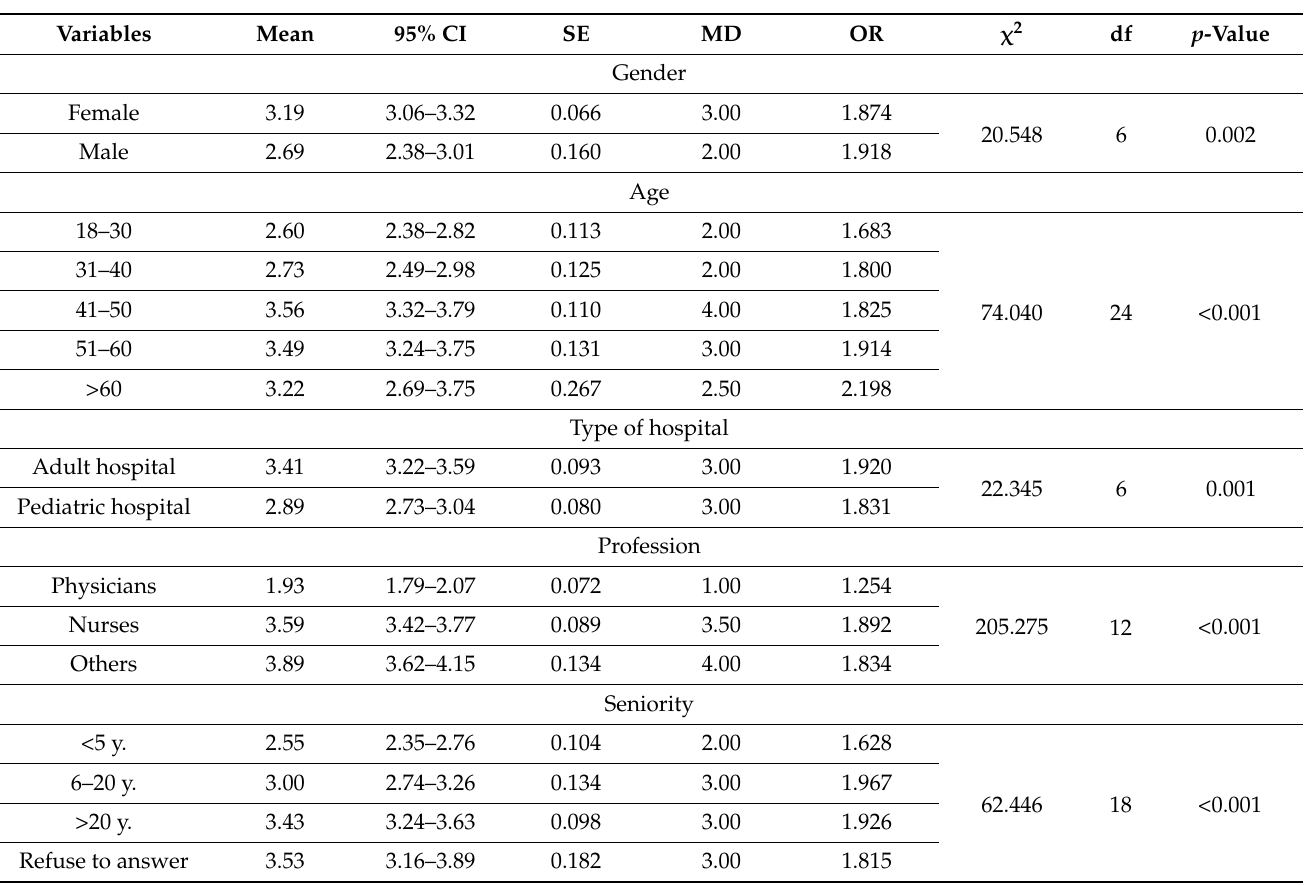
Table 9. Taking vitamin C daily to prevent influenza virus infection by sociodemographic category ( N =